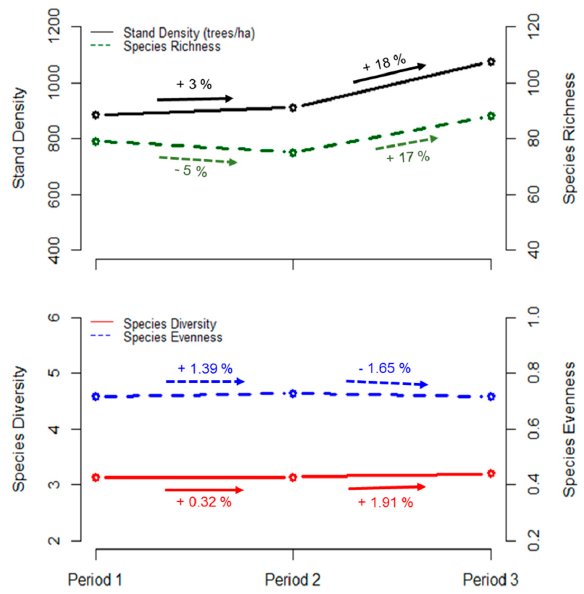
Figure 2. Change in stand density, species richness, diversity, and evenness over 15 years.